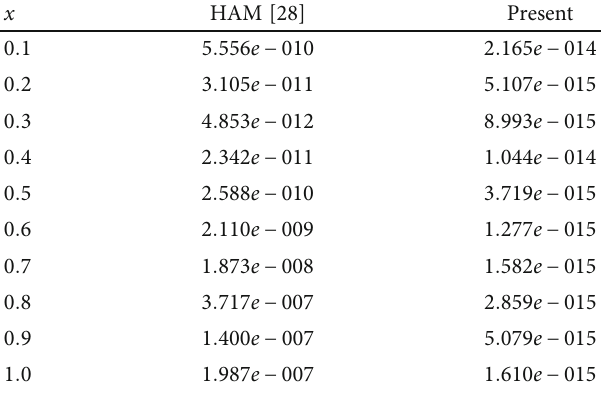
Table 3: Comparison between relative errors of HAM [28] and present results varied x of Example